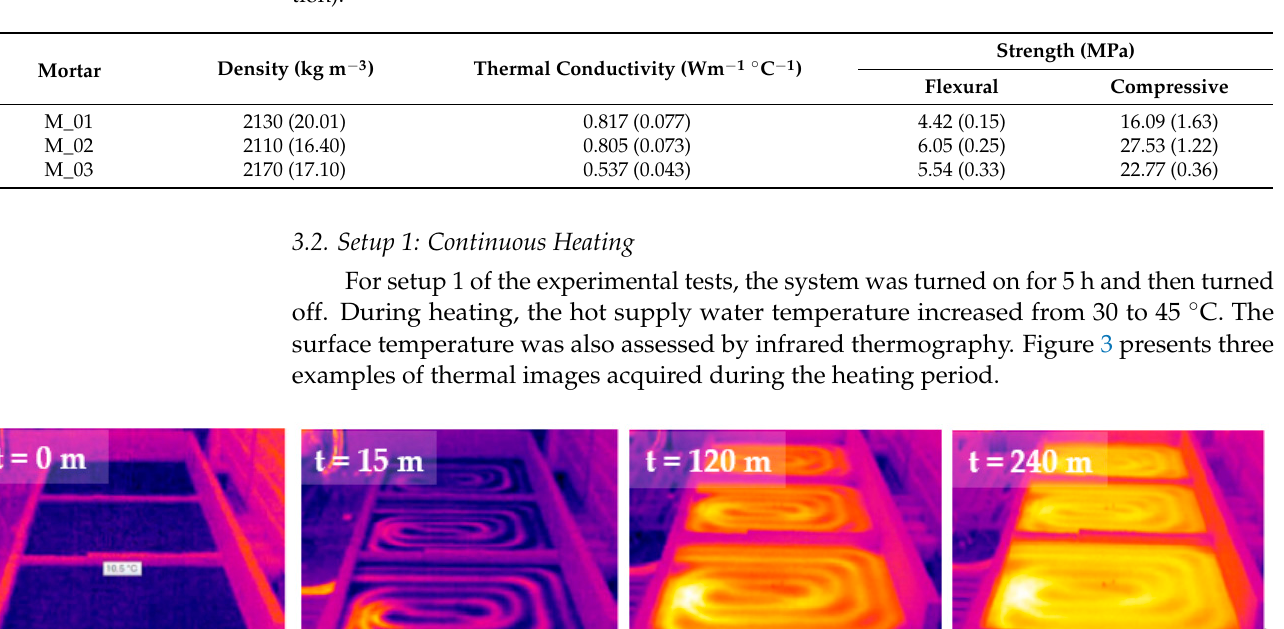
Figure 3. Thermal images taken throughout the heating period (m, minutes).